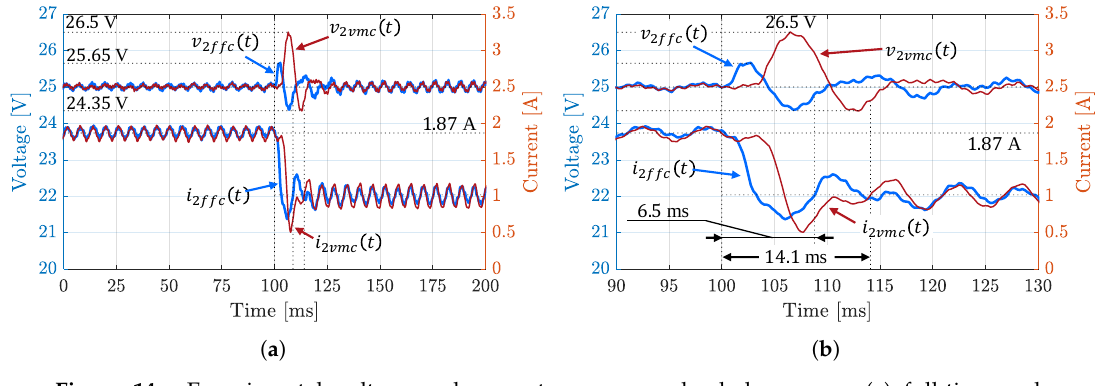
Figure 14. Experimental voltage and current responses: load decreases. ( a ) full-time scale; ( b ) zoomed-in view of the transient